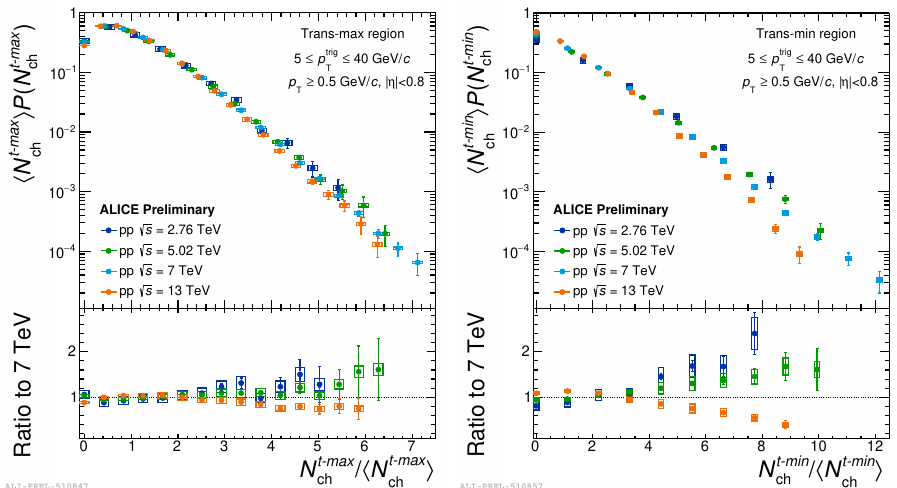
Figure 3: Top: multiplicity distributions in KNO variables in the trans-max (left) and trans- min (right) regions for pp collisions at √ s = 2 . 76, 5.02, 7 and 13 TeV. Bottom: the KNO multiplicity distributions are normalized to that for pp collisions at √ s = 7 TeV. The boxes and the error bars represent the systematic and statistical uncertainties,